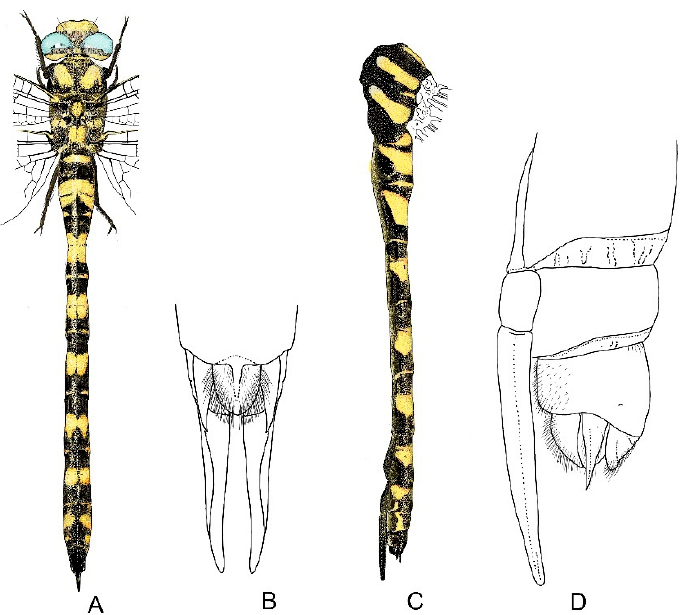
Figure 16. Cordulegaster cilicia sp. nov., paratype ♀ , (RMNH, leg. G. A. Mavromoustakis, RMNH.INS.1090164, 21 June 1960, North Lebanon, Bcharre, 34.2511° N, 36.0111° E, 1400 m a.s.l.): ( A ): habitus, dorsal. ( B ): appendages, dorsal. ( C ): habitus, lateral. ( D ): ovipositor, lateral. Thorax (Figure 16A,C): much as in male, except the yellow markings of metepisternum; metepisternum black with prominent comma-shaped yellow markings. Wings : like in male, hyaline; Pt dark brown, Pt FW 4.4 × 0.7, HW 4.8 × 0.6; membran- ula